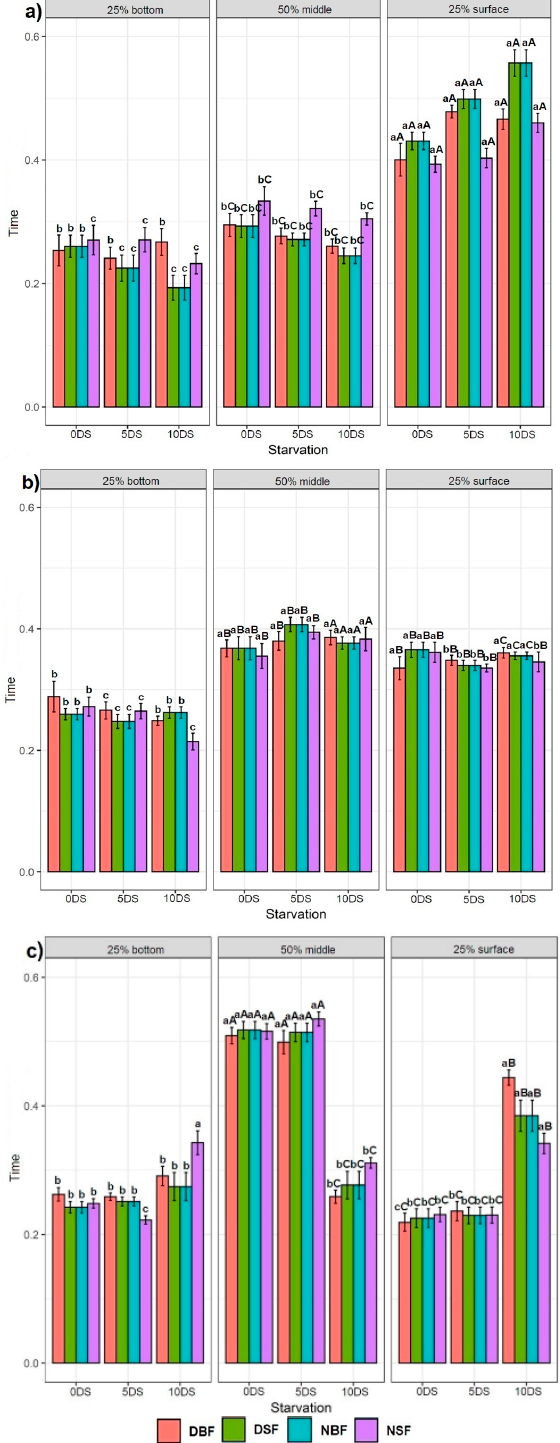
Figure 3. Effect of time points on the Siberian sturgeon swimming preference between three tank sections: ( a ) on the first recording day at 68 dph, ( b ) on the second recording day at 89 dph, and ( c ) on the third recording day at 110 dph. Letters denote significant differences, where the lowercase letters show the difference for each feeding application for one day of starvation between tank sections per recording day. The uppercase letters show the difference for each feeding application per one day of starvation for each tank section between three recording